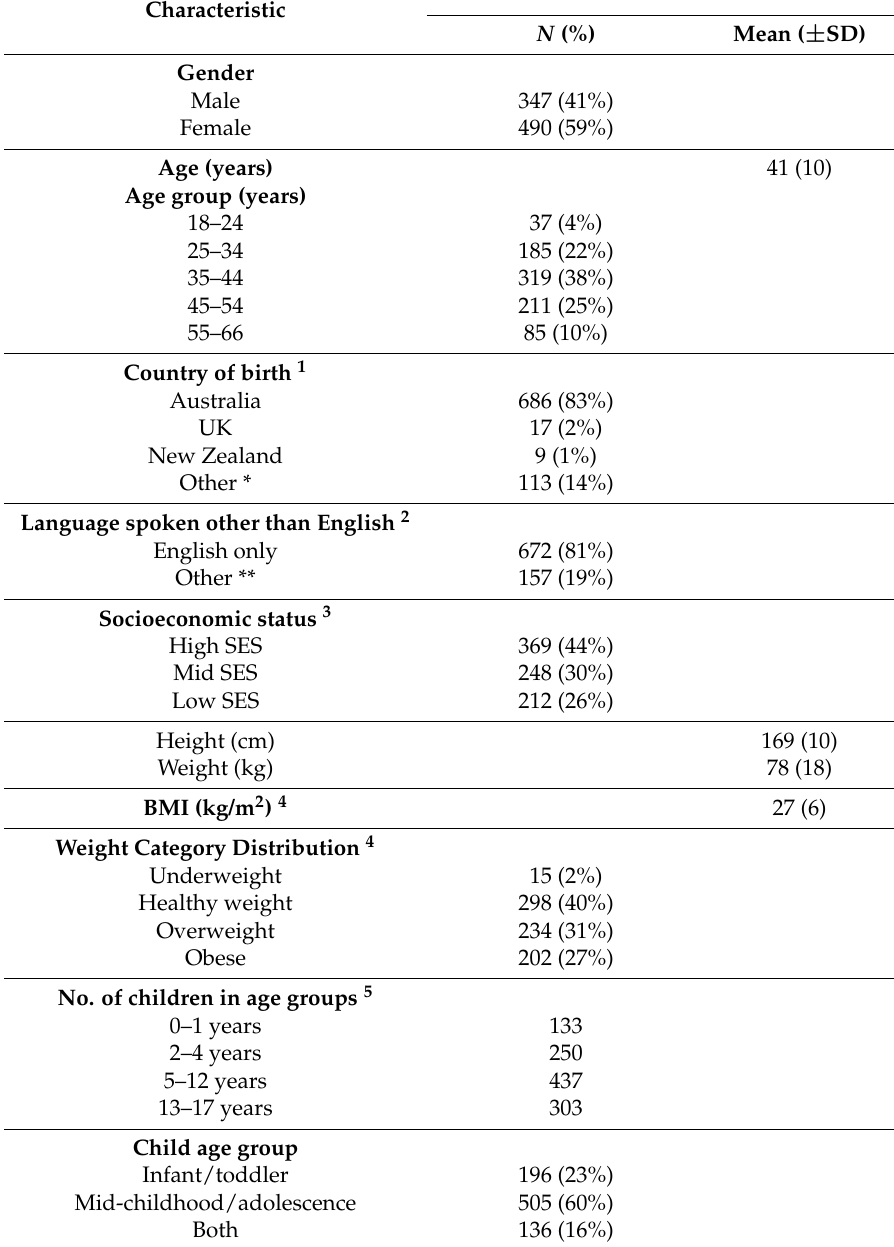
Table 1. Demographic characteristics of parents ( n =